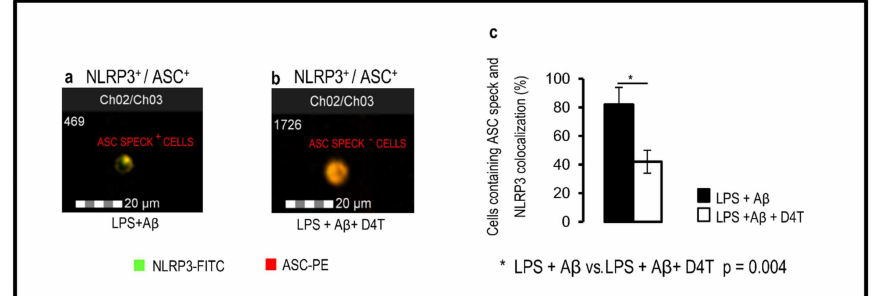
Figure 1. Inflammasome production and ASC-speck formation. Representative images of Nod- like receptor protein 3 (NLRP3) expression and apoptosis-associated speck-like-protein containing CARD (ASC)-speck formation. ASC-speck ( a ) and ASC-diffuse ( b ) images were obtained by AMNIS FlowSight-merged (Ch02/03) NLRP3-FITC (Ch02) and ASC-PE (Ch03) fluorescences; analysis of ASC-speck and its co-localization with NLRP3 was performed by IDEAS software, which provides tools to evaluate image regions (masks) and perform calculations (features). The percentage of ASC-speck-positive cells is shown in panel ( c ). Statistical significance is